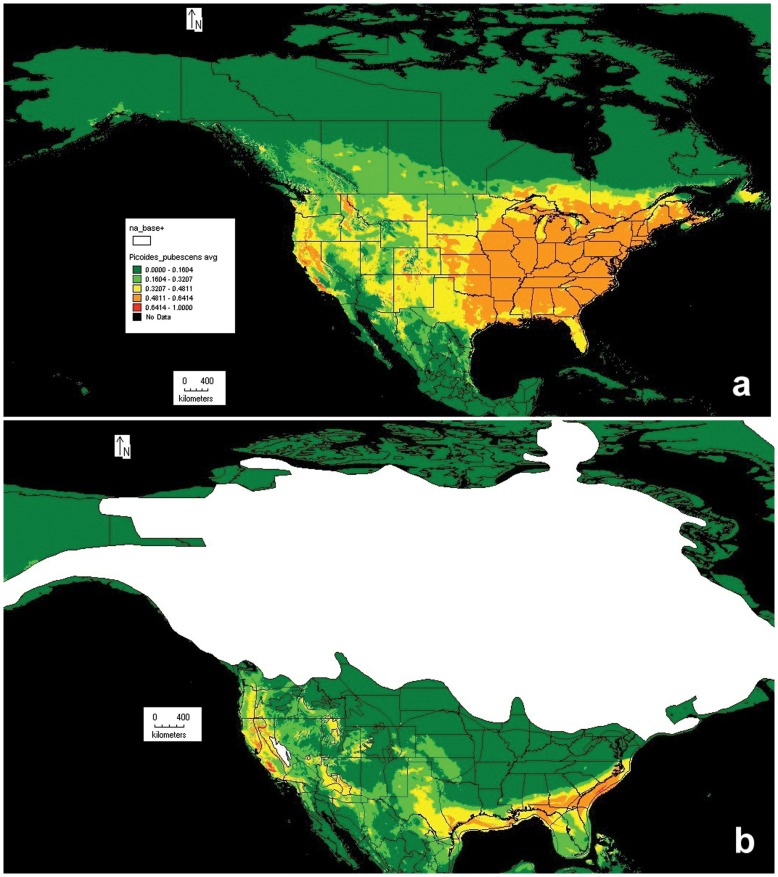
Current (a) and LGM (b) species distribution model of the Downy Woodpecker as modeled with 19 bioclimatic variables [see 81].Warmer colors reflect areas with higher probabilities of occurrence. The distribution of the ice sheets (white) follows [39].